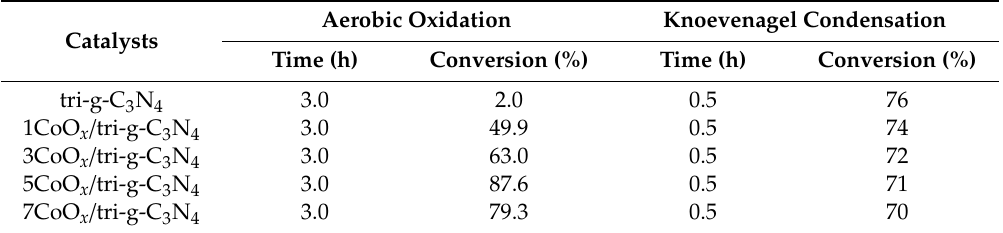
Table 3. Catalyst activity of aerobic oxidation and Knoevenagel condensation.